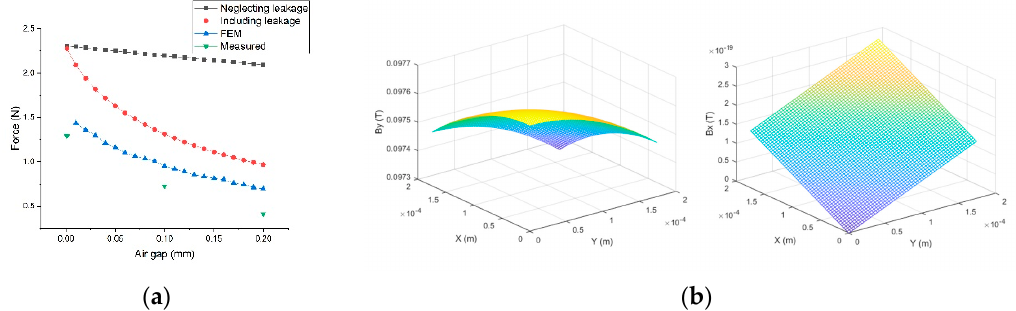
Figure 8. Gripper with the external EM: ( a ) Experiment results and comparisons of the force predicted by external EM; ( b ) Air gap density distribution of the three poles.